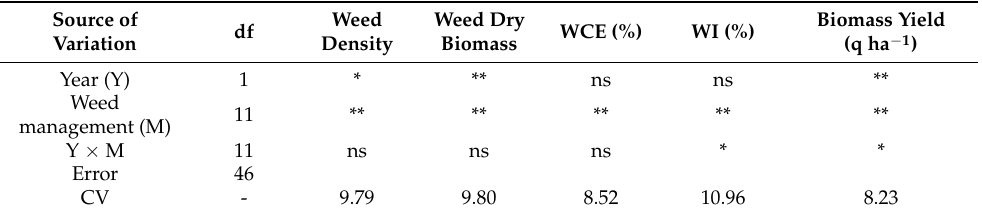
Table 3. Analysis of variance for the effect of weed management treatments on weed parameters at 75 DAT and the yield at harvest of T. minuta . df